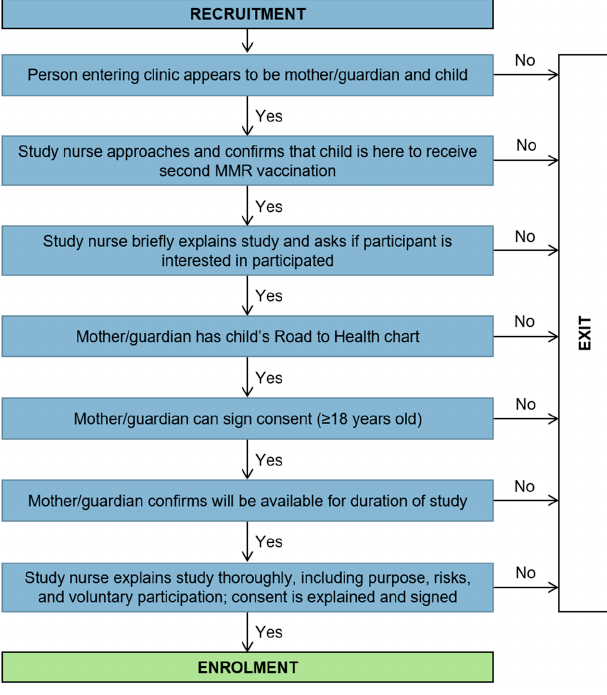
Figure 4. Enrolment stage flow chart.